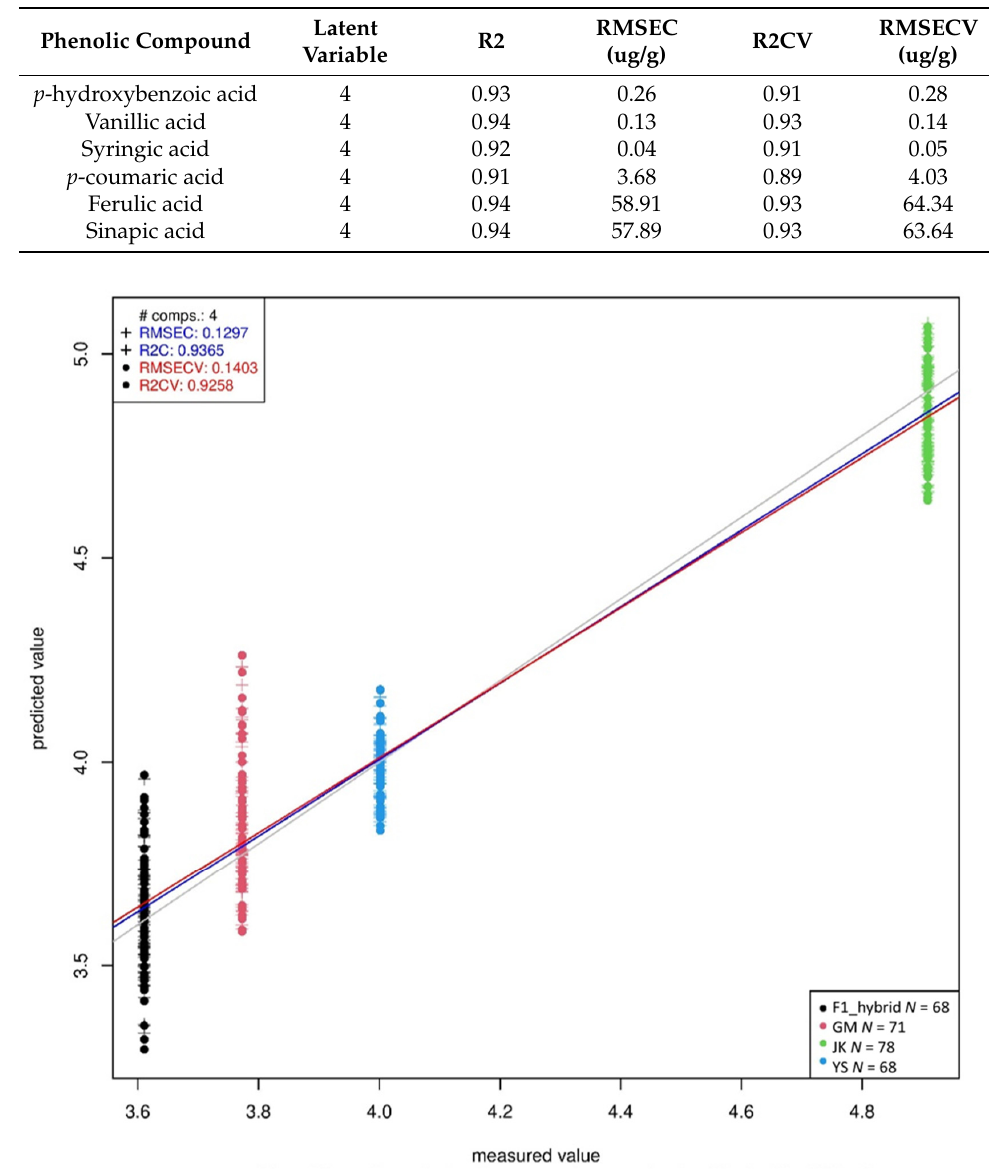
Figure 5. Partial least squares regression (PLSR) prediction of vanillic acid in all the plants.